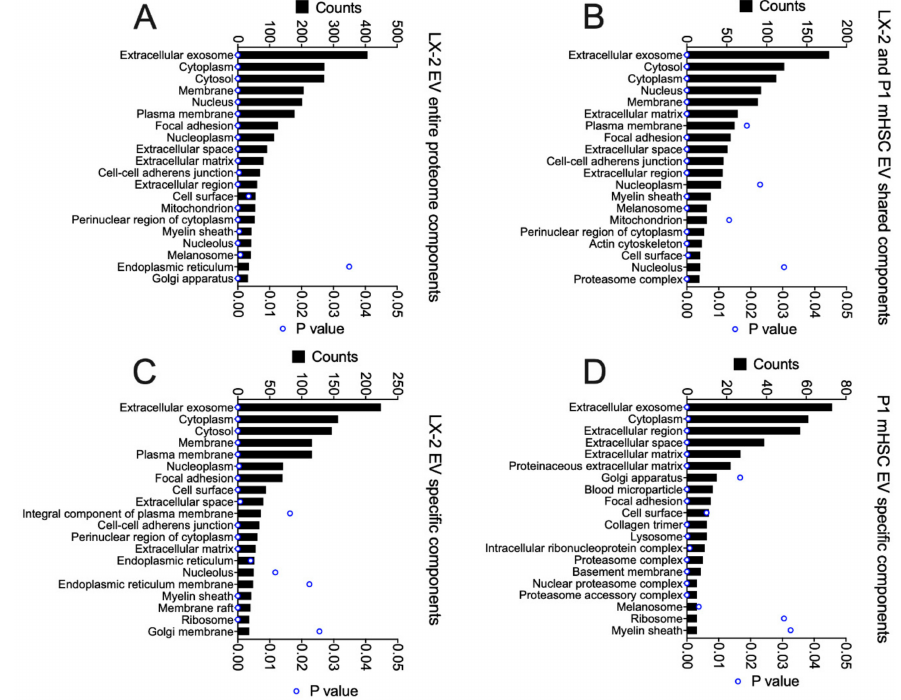
Figure 8. Cellular component analysis of proteins in EVs from LX-2 hHSC and / or P1 mHSC.